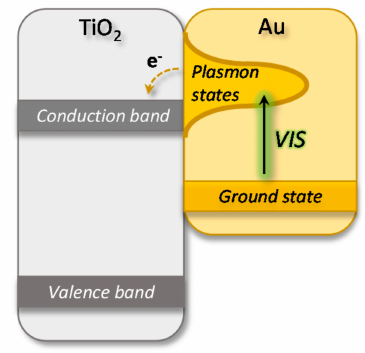
Figure 5. Schematic illustration of hot electron transfer from an excited plasmonic state on the gold nanoparticle, to the TiO 2 conduction band. Modified from reference